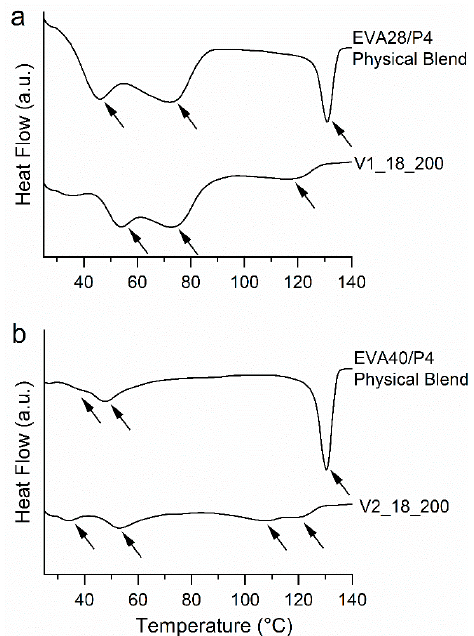
Figure 5. Di ff erential scanning calorimetry (DSC) thermograms of physical blends and vacuum Figure 5. Differential scanning calorimetry (DSC) thermograms of physical blends and vacuum compression molding (VCM) systems: ( a ) EVA28 / progesterone (P4) systems, and ( b ) EVA40 / P4 systems. compression molding (VCM) systems: ( a ) EVA28/progesterone (P4) systems, and ( b ) EVA40/P4 Arrows indicate thermal systems. Arrows indicate thermal events.